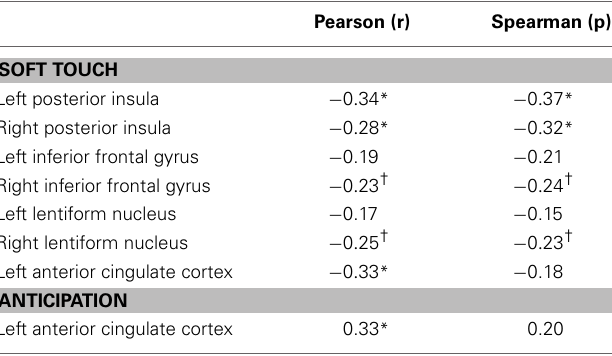
Table 5 | ROI activation from group by condition analyses correlated with